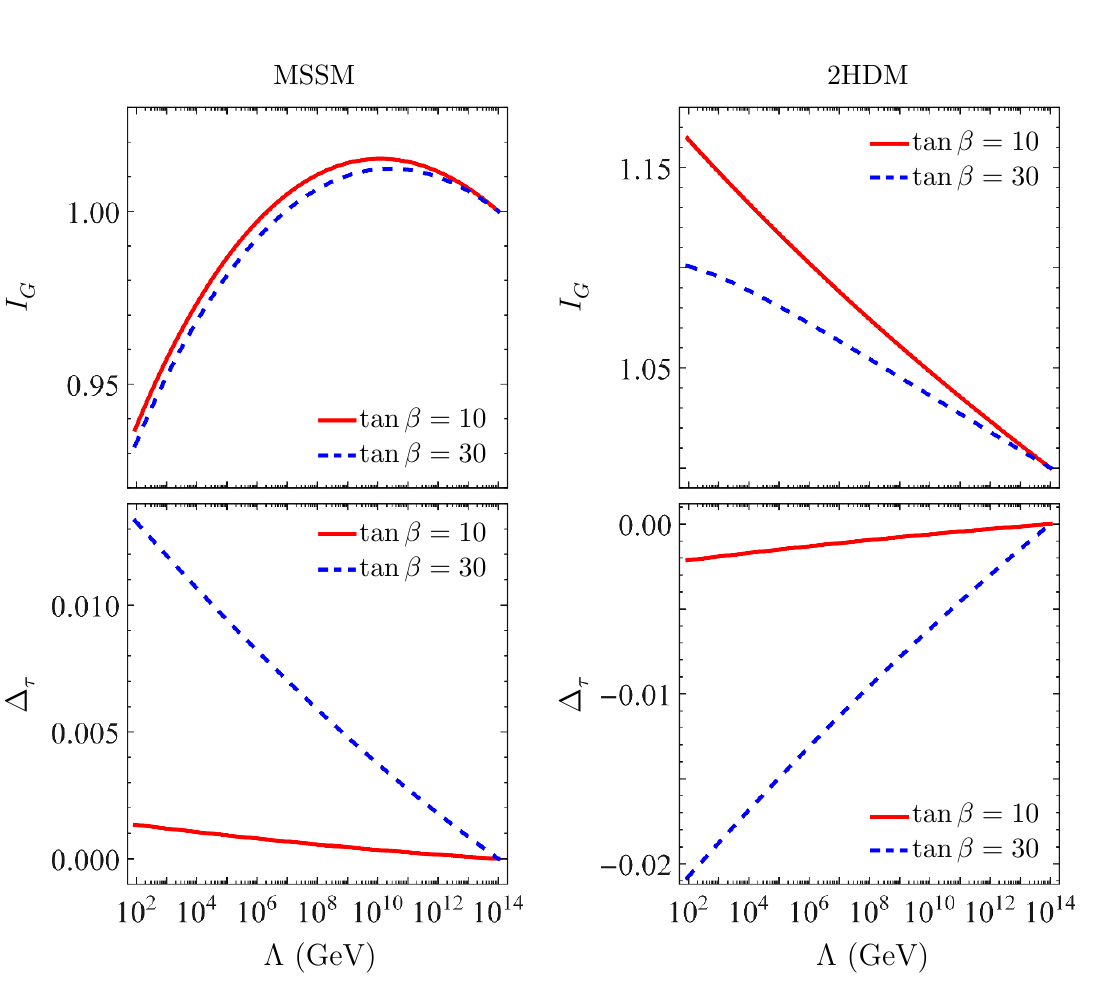
and ∆ versus the energy scale Λ in the MSSM or the type-II 2HDM. τ G